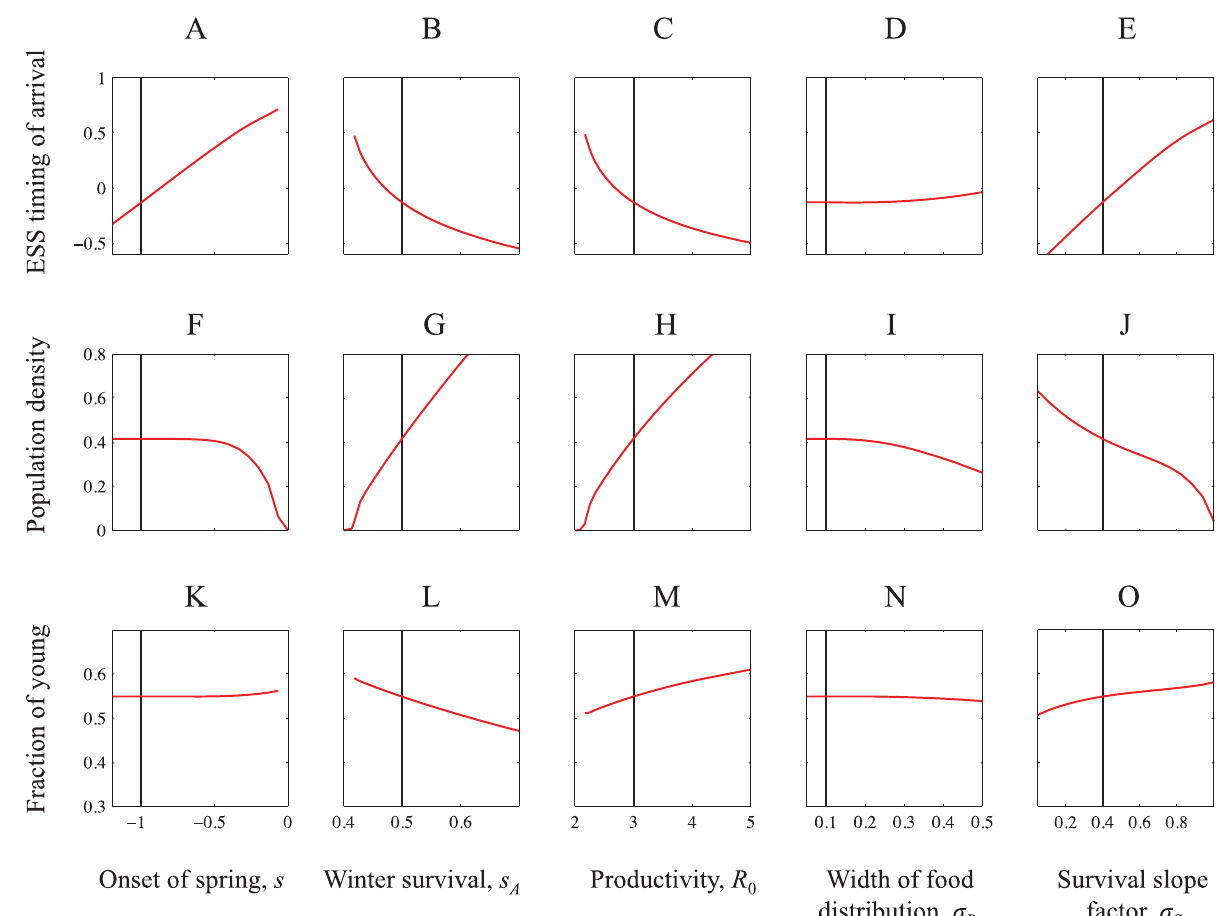
Figure 2. Properties of the ecological and evolutionary equilibrium. The panels show how ESS timing of arrival ( A – D ) and the corresponding equilibrium population density ( E – H ) and fraction of young at equilibrium ( I – L ) depend on model parameters. When not varied as indicated by the graphs, the parameters under study are set to s = (cid:2)1, s = 0.1. These values are indicated by the vertical line which thus represents the same and (cid:2) R parameter settings across panels. Remaining parameter values: r = 1, S = 0.4, k = 0.5 (note that s = ks (cid:2) S J A